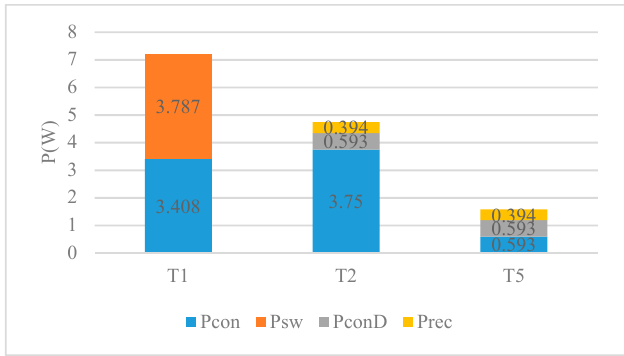
Figure 7. Loss distribution of T1, T2, and T5 in Si-only topology.